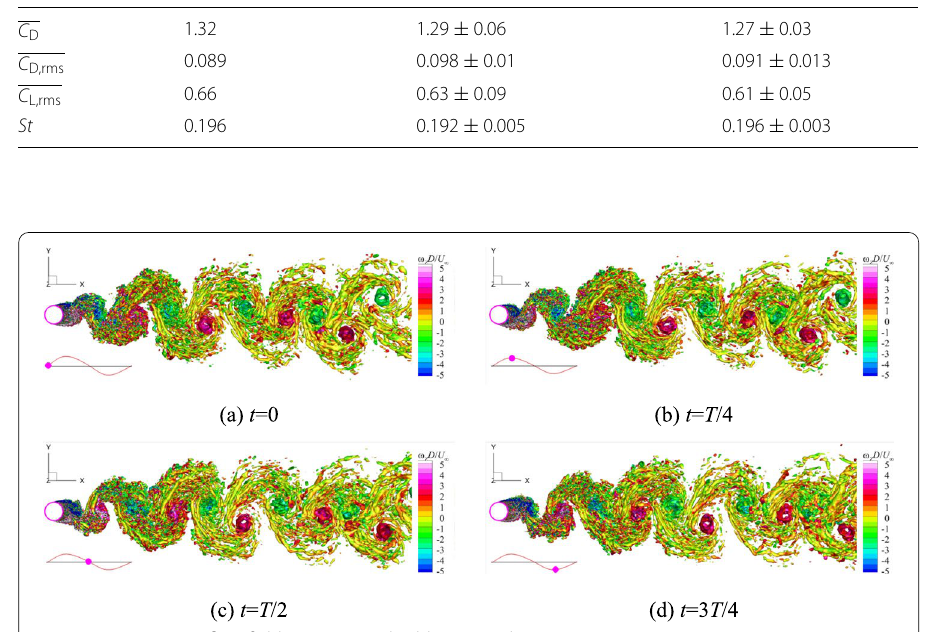
Fig. 5 Instantaneous flow fields in a vortex shedding